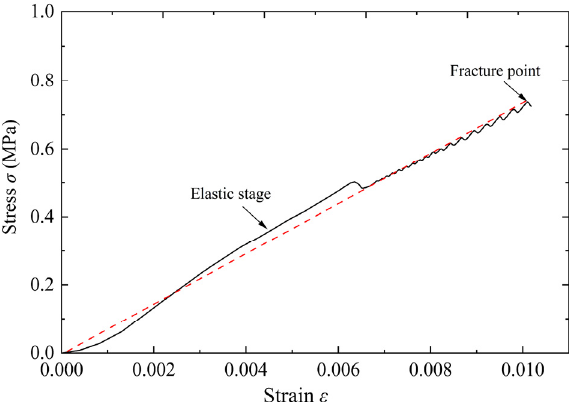
Figure 4. Four-point bending failure process of foamed concrete ( a ) Test layout; ( b ) Crack propagation; ( c ) Fracture morphology.